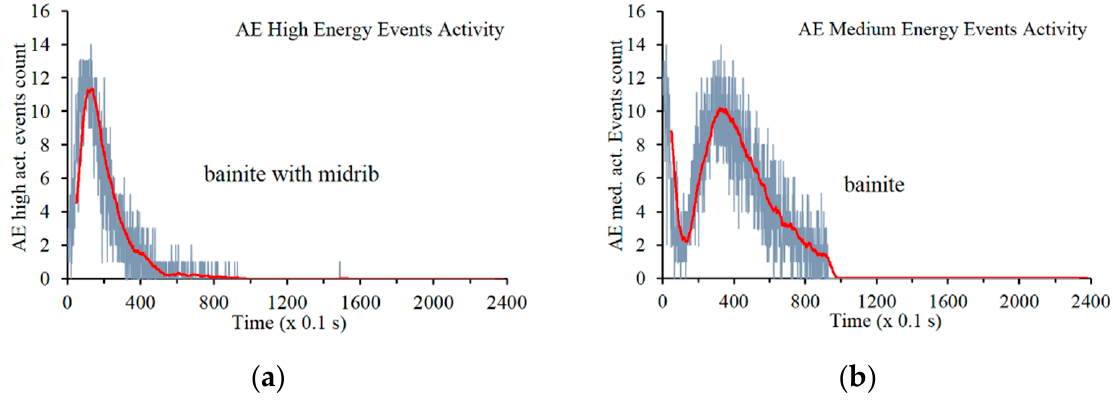
Figure 11. Relationship of the detected AE events correlated with patterns: ( a ) for high-energy AE events and ( b ) for medium-energy AE events.